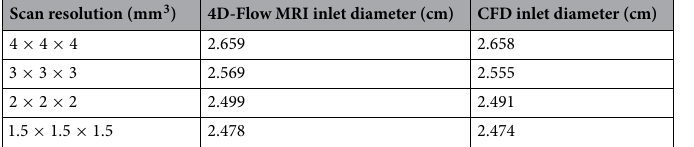
Table 3. Inlet plane diameters for all 4D-Flow MRI scans calculated using 4D-Flow MRI data and CFD